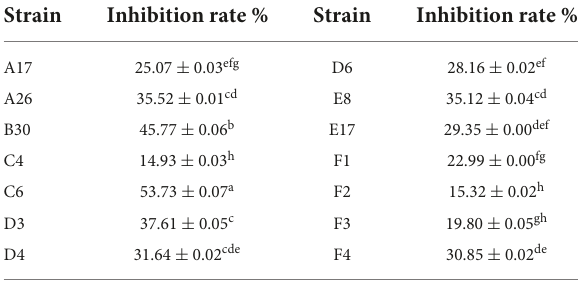
TABLE 4 Inhibition rate of volatile metabolites of Trichoderma strains against Sclerotinia asari (x ± s, n = 3).